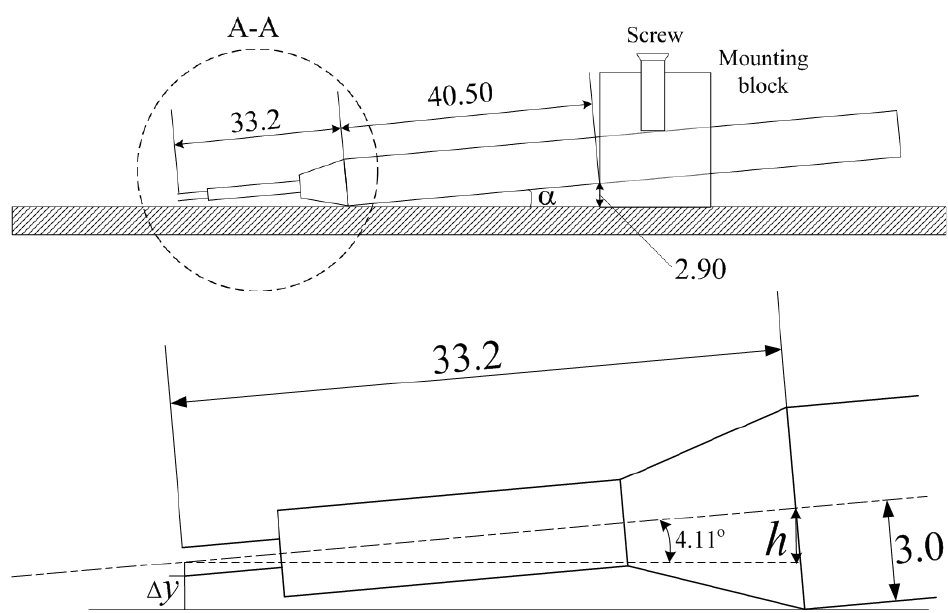
Figure 1. Installation of the hot-wire probe on train roof (all length dimensions are in mm).